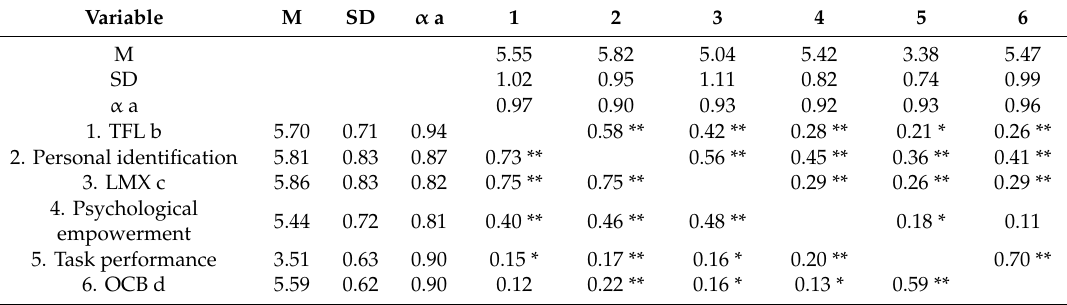
Table 2. Variable Means, Standard Deviations, Correlations, and Reliabilities.